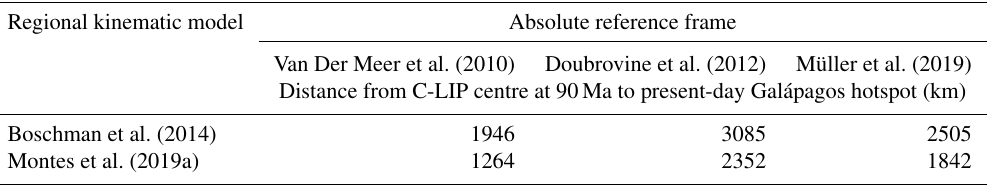
Table 3. Summary of the kinematic models used to test the origin of the C-LIP in the Galápagos hotspot (0 ◦ N, 91 ◦ W; Nolet et al., 2019) and the corresponding distance to the centre of the Caribbean plateau at